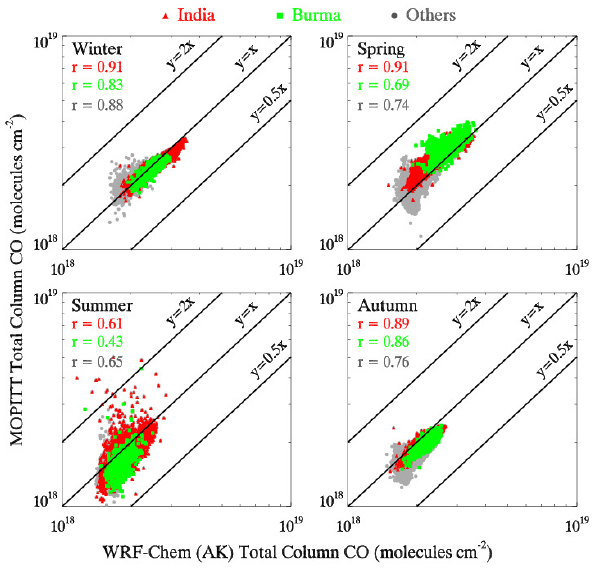
Figure 10: Scatter plot between seasonally averaged WRF-Chem simulated and MOPITT 1321 Fig. 10. Scatter plot between seasonally averaged WRF-Chem retrieved total column CO during winter, spring, summer and autumn of the year 2008. Others 1322 simulated and MOPITT-retrieved total column CO during winter, correspond to the areas not covered by regions 1-5 shown in Figure 1. The correlation 1323 spring, summer and autumn of the year 2008. Others correspond to coefficients for each region are also shown. 1324 the areas not covered by regions 1–5 shown in Fig. 1. The correla- tion coefficients for each region are also shown.